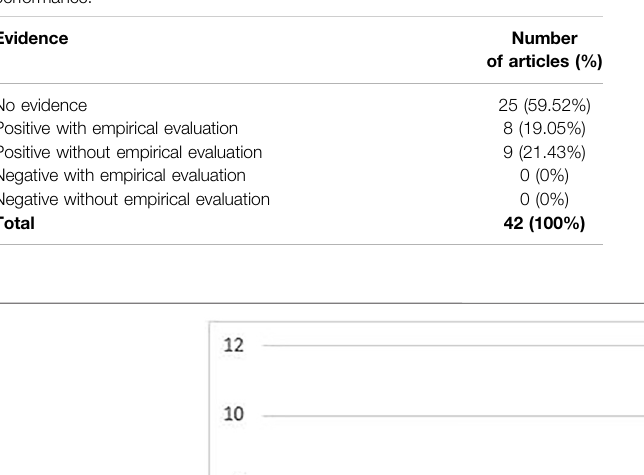
TABLE 6 | Evidences that Learning Analytics improves high school student performance.